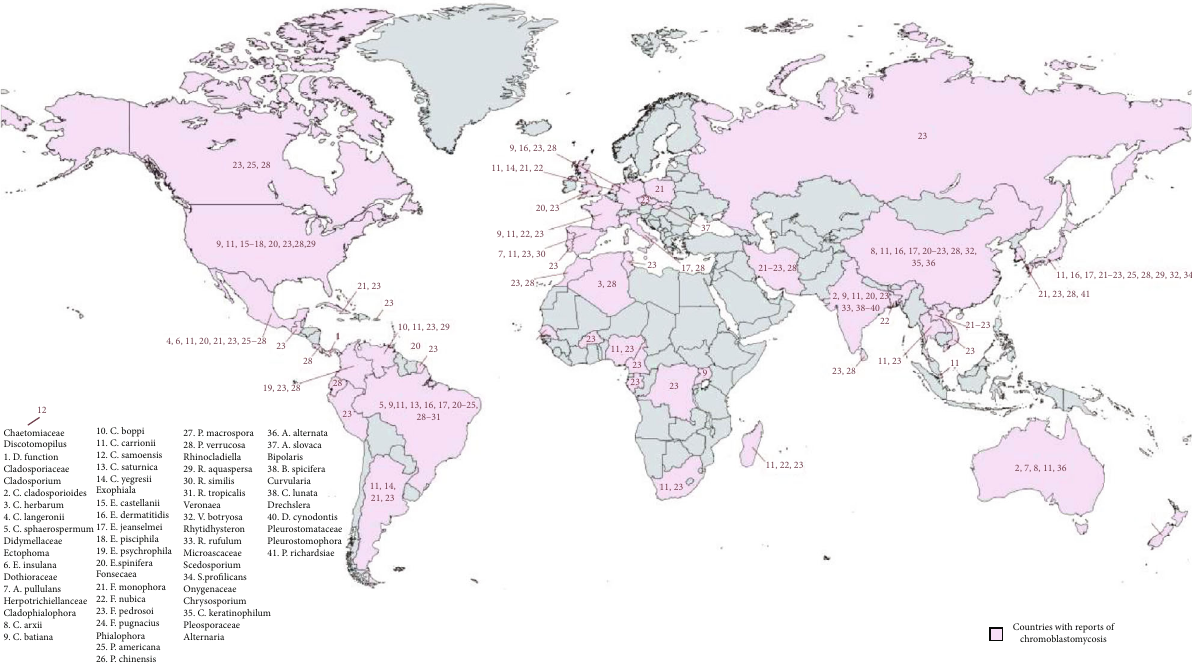
Figure 1: World distribution of fungal species responsible for CBM in humans. Each number on the map represents one species, shown in